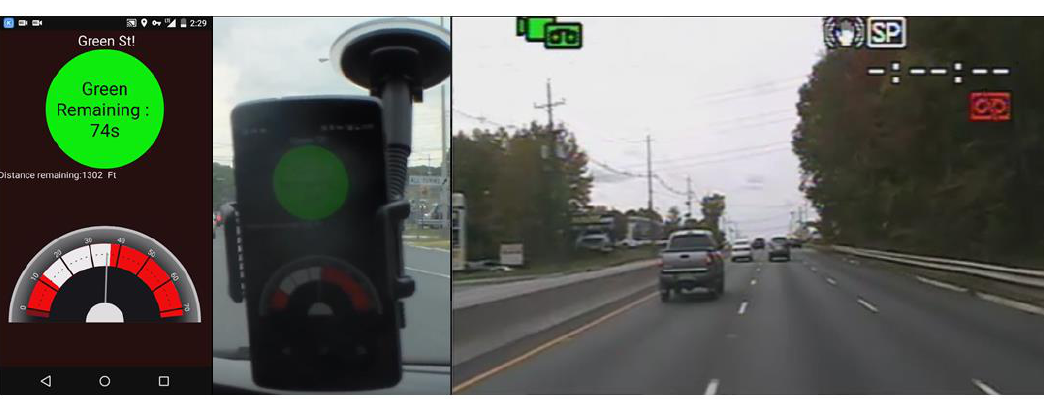
Figure 7. ITSAS field test.